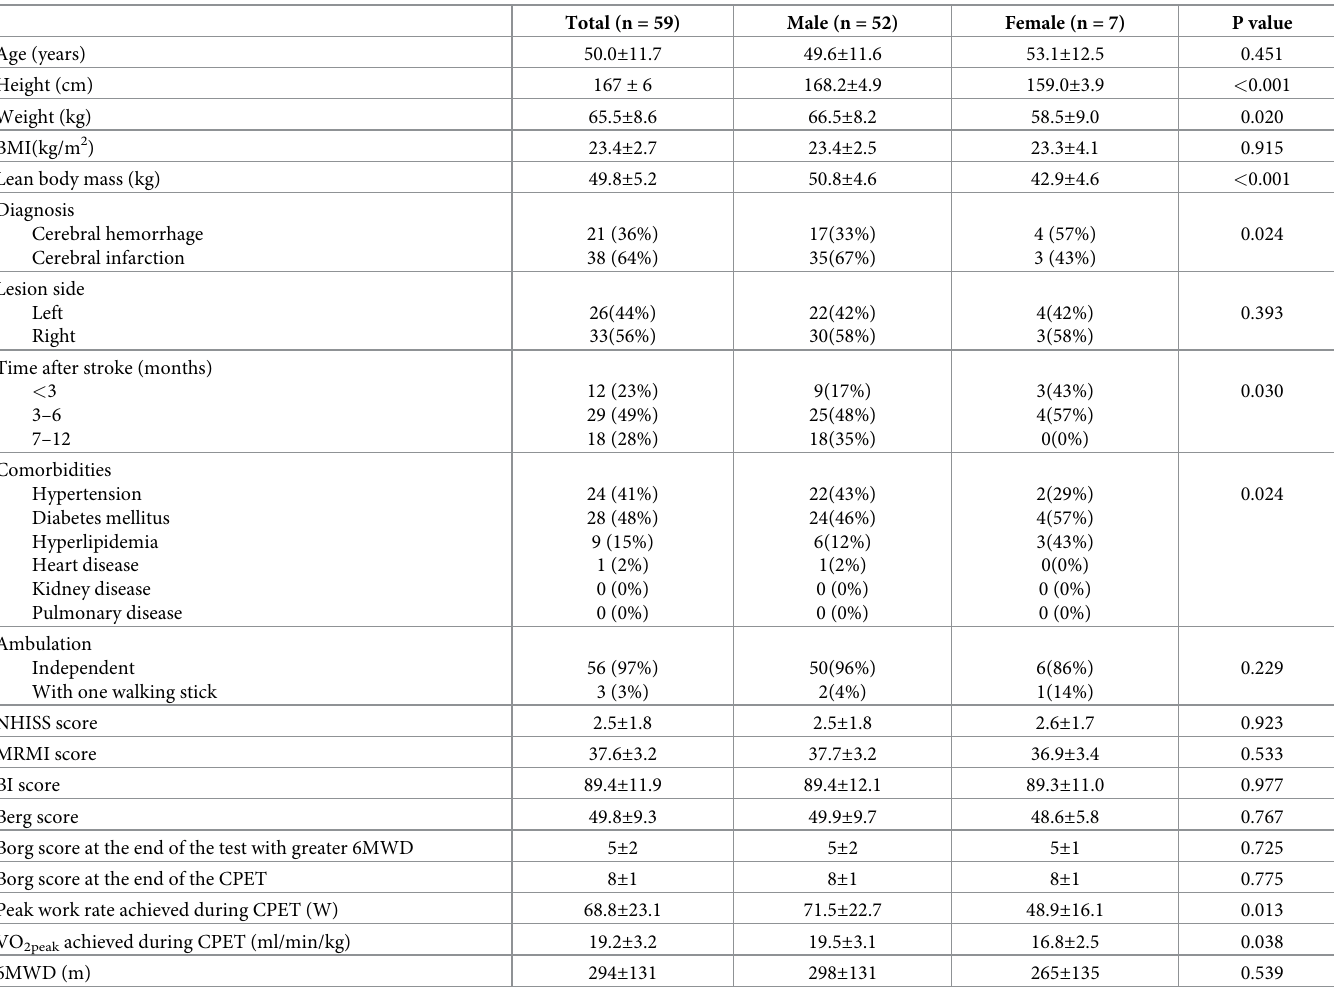
Table 1. Demographic data and clinical characteristics of the 59 participants. Data in n (%) or mean ±